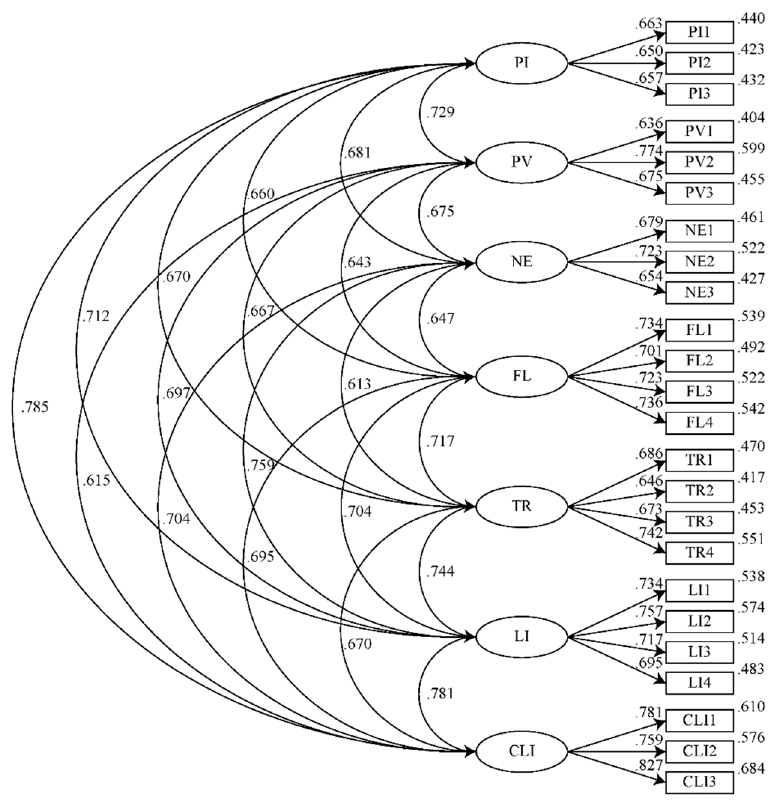
Figure 2. First-order CFA results. Table 5. Model fitting index comparison results of CFA and CCLFM.